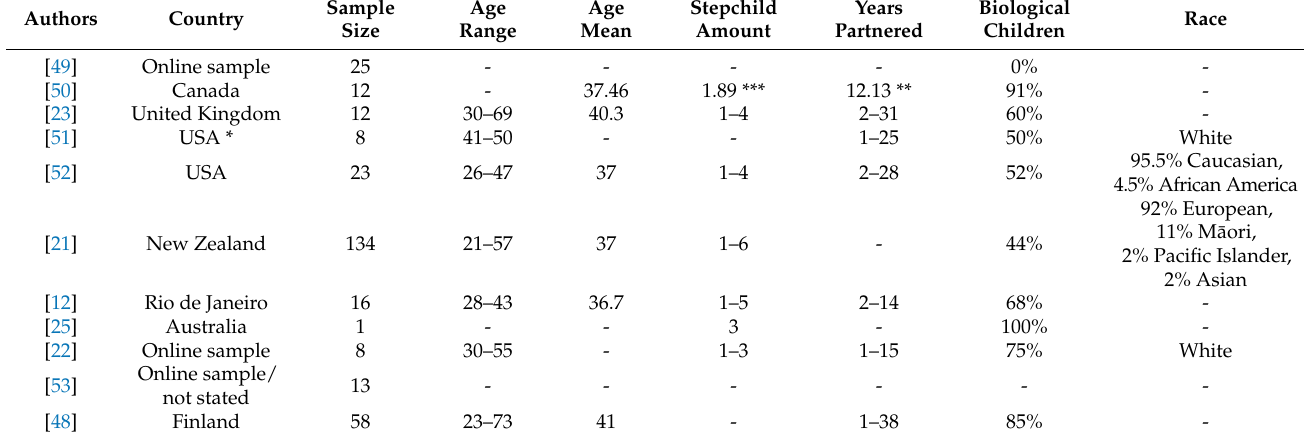
Table 2. Sample characteristics.